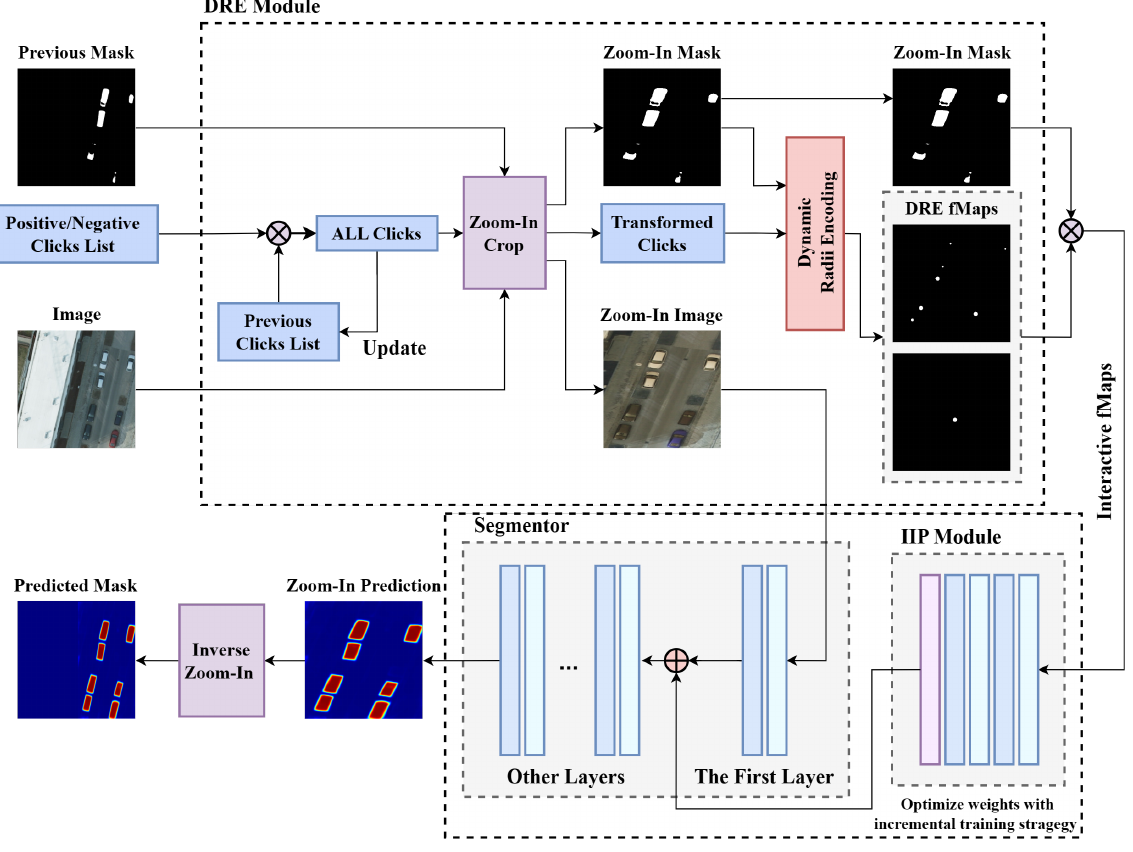
Figure 2. The pipeline of DRE-Net. The symbols “ ⊗ ” and “ ⊕ ” indicate concatenation and addition operations,